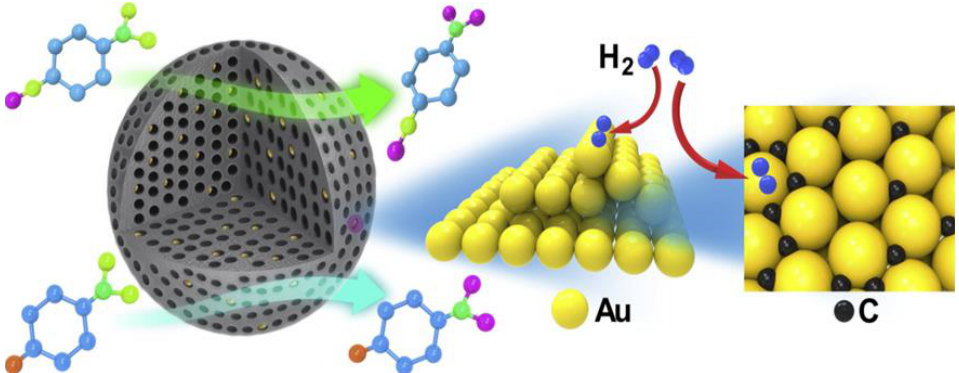
Figure 7. As a heterogeneous catalyst for the selective reduction of aromatic nitro compounds, ther- mally reduced gold nanocatalysts were made by carbonizing ordered mesoporous carbon. Adapted with permission from ref. [29].